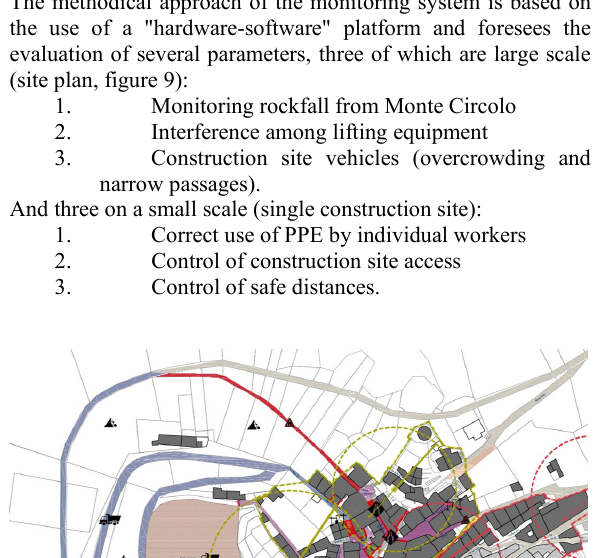
Figure 5, 6, 7: in order from left to right: RFID passive TAG from FARSENS; Autonomous sensors for Structural and Environmental Monitoring of Dynamic Events already presented in [2]; Commercial RFID reader from Impinj used in the F. The different sensors are scattered in the area of the construction site and periodically send data detected by a gateway (collection point), which acquires the data, manages the worker in order to protect him against one or more risks likely to threaten his safety or health during work.